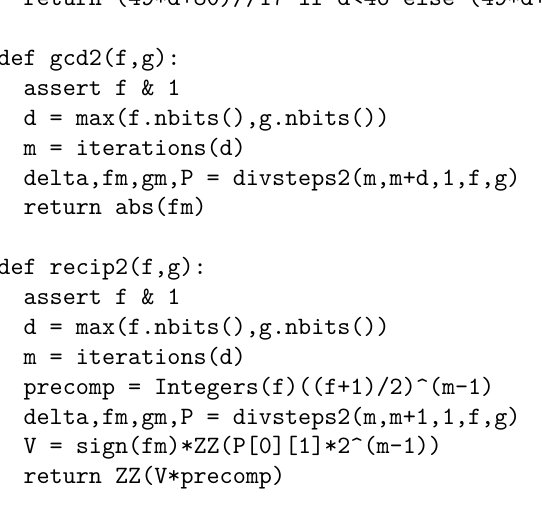
Figure 11.1: Algorithm gcd2 to compute gcd { f, g } ; algorithm recip2 to compute